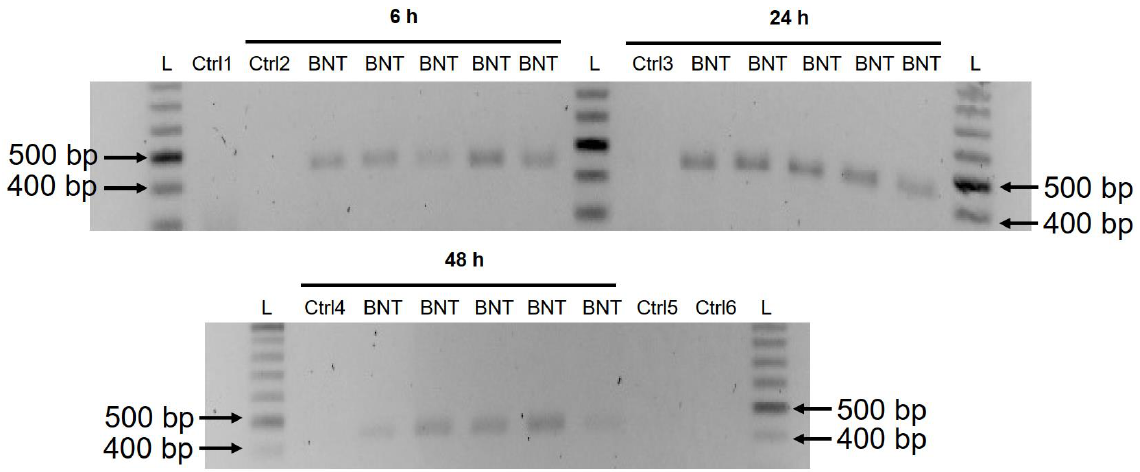
Figure 5. Detection of DNA amplicons of BNT162b2 in Huh7 cells treated with BNT162b2. Huh7 cells were treated without (Ctrl) or with 0.5 µ g/mL of BNT162b2 for 6, 24, and 48 h. Genomic DNA was purified and digested with 100 µ g/mL RNase. PCR was run on all samples with primers targeting